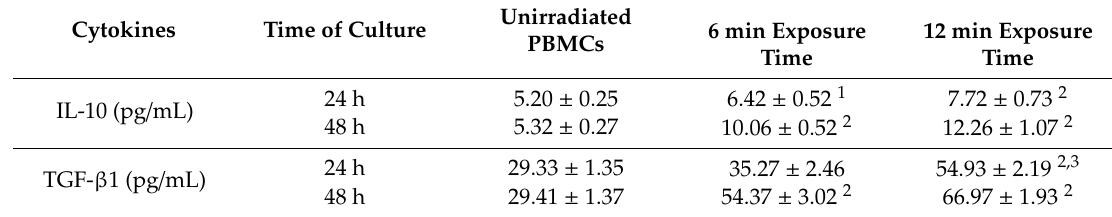
Table 2. E ff ects of exposure to PILER lamp on the regulatory cytokines production by cultured PBMCs. Cytokines Time of Culture